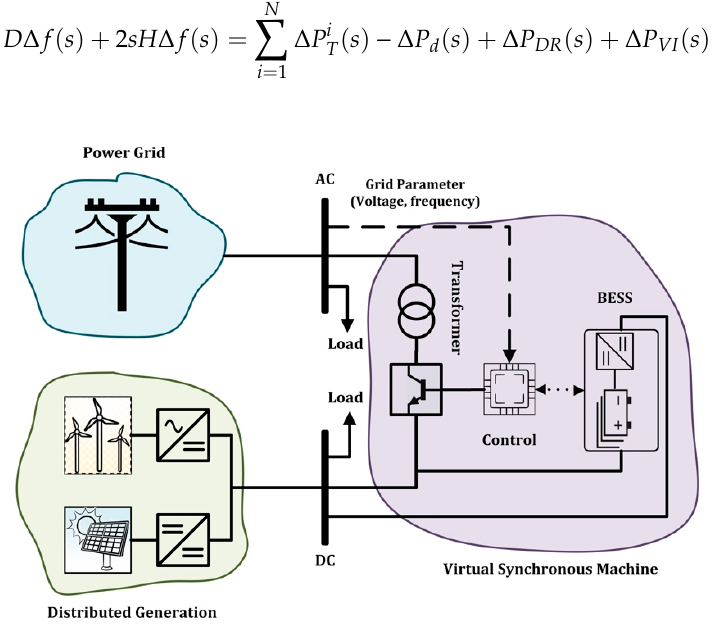
Figure 3. Configuration of control system for utilization of BESS for frequency regulation.